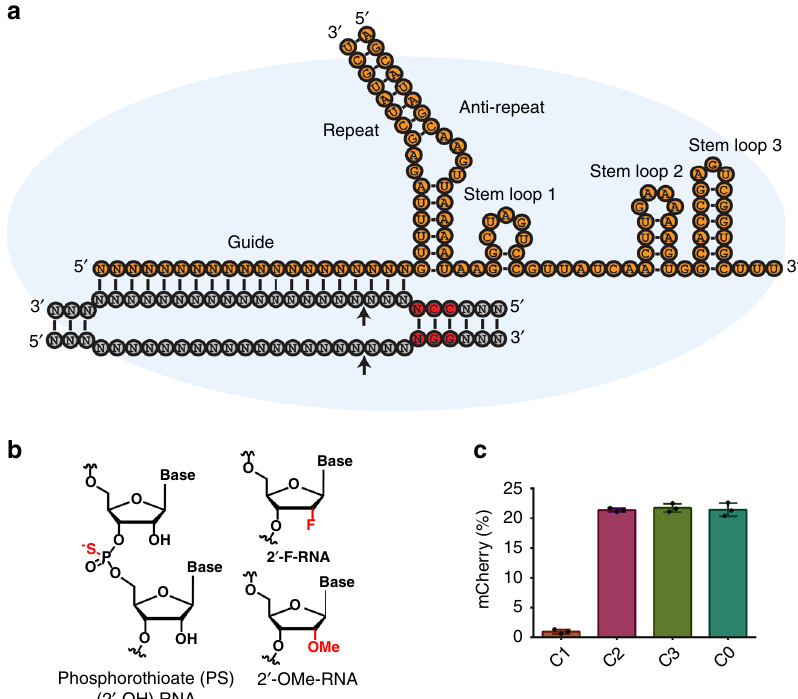
Fig. 1 Initial screening of chemical modi fi cations in the crRNA. a Schematic of Cas9 RNP paired with target DNA. The secondary structure elements of crRNA and tracrRNA are labeled. RNA is shown in orange, whereas DNA is in gray. The PAM sequence is highlighted red and cleavage sites are marked with arrows. b Chemical modi fi cations used in this study. c Bar graph showing mCherry-positive cells after electroporation of HEK293T-TLR cells with RNPs that included the indicated crRNAs and an unmodi fi ed tracrRNA. Error bars represent standard deviation (SD) resulting from at least three biological